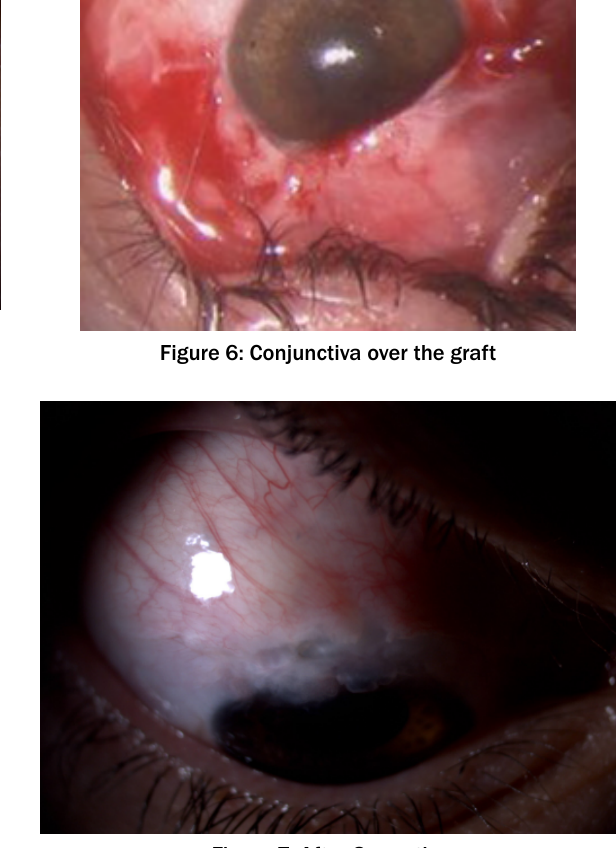
Figure 7: After 8